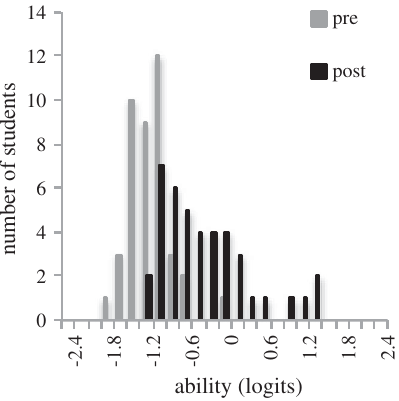
FIG. 37. The pre- and postability histogram for class 23.